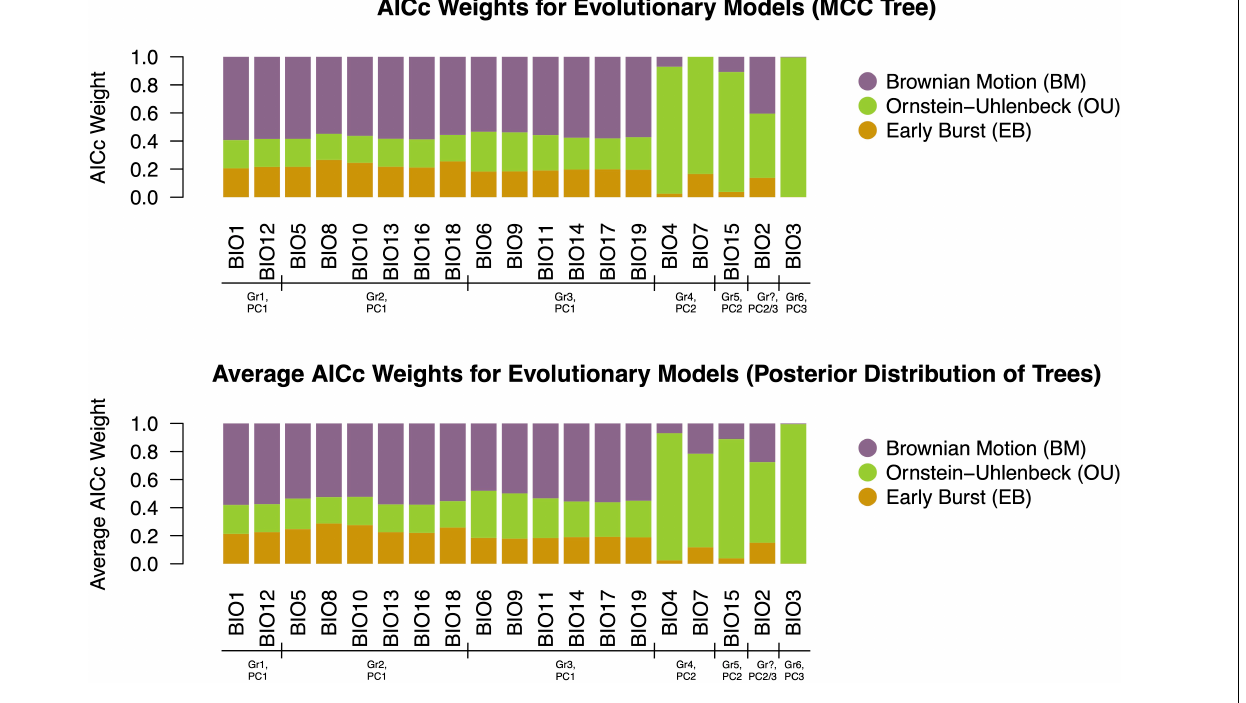
FIGURE 3 | AICc weights for three models fit to 19 bioclimatic variables on the MCC tree and 1,000 trees derived from the posterior. The BM model of evolution best described the evolution of most traits. Exceptions to this trend included BIO3, BIO4, BIO7, and BIO15, in which an OU process was overwhelmingly favored. Additionally, support for an OU model was equal to or slightly higher than that of BM for trait BIO2. For all other traits, support for OU and EB models was comparable, but substantially less than that of